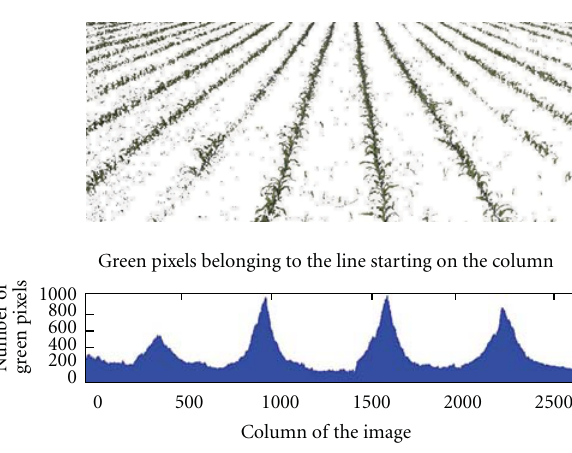
Figure 6: Number of green pixels found for the best line of every pixel of the bottom